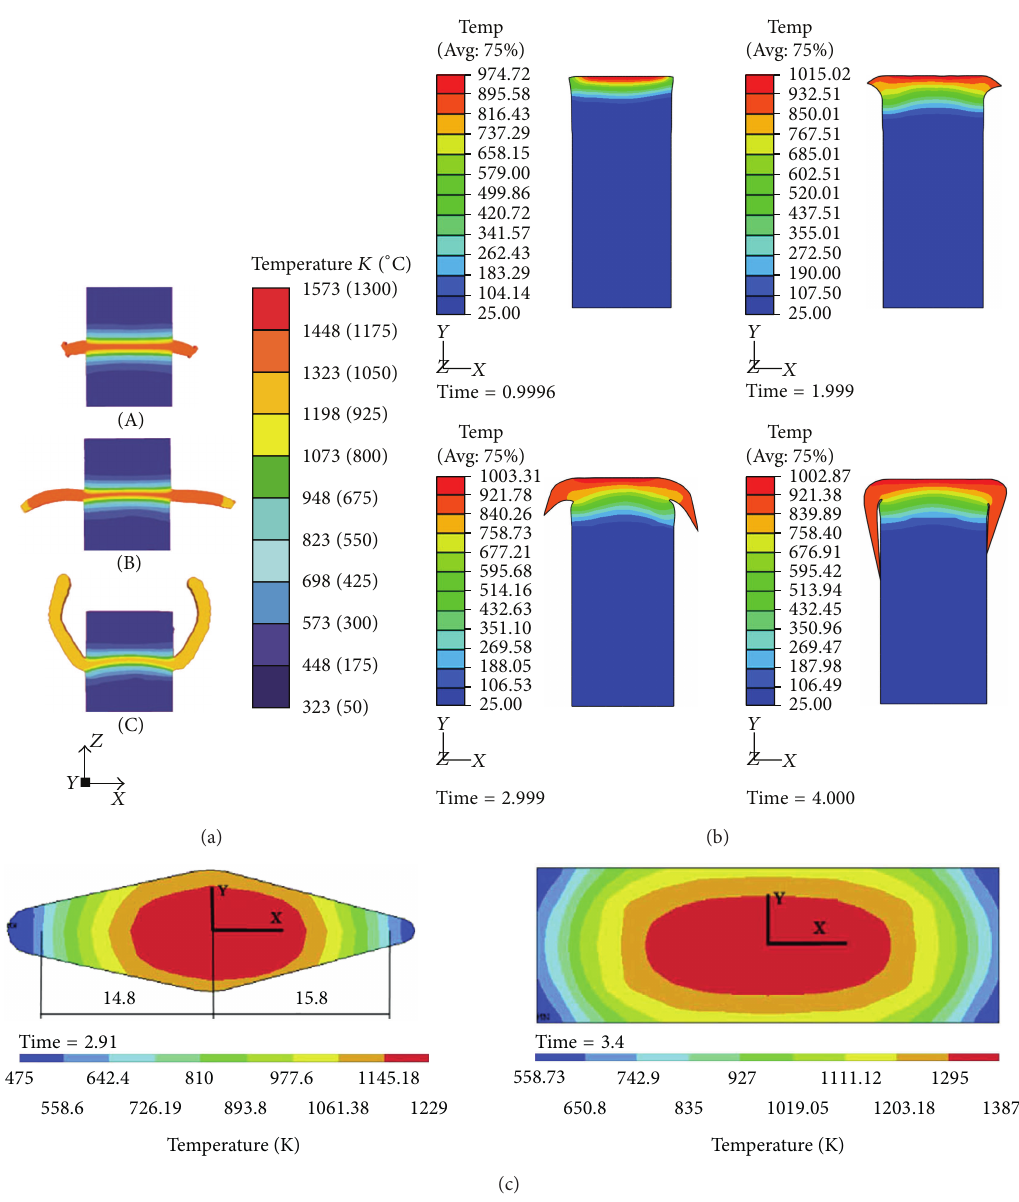
Figure 5: (a) Thermal profiles predicted for 2D LFW simulation considering both sides of the weld, at three different pressures: (A) low pressure, (B) medium pressure, and (C) high pressure [13]. (b) Thermal profile predicted for 2D LFW simulation considering only one side of the weld, for Ti-6Al-4V, at different times during the process [6]. (c) Thermal profile on the weld interface for a 3D LFW simulation, considering a “blade-representative” geometry